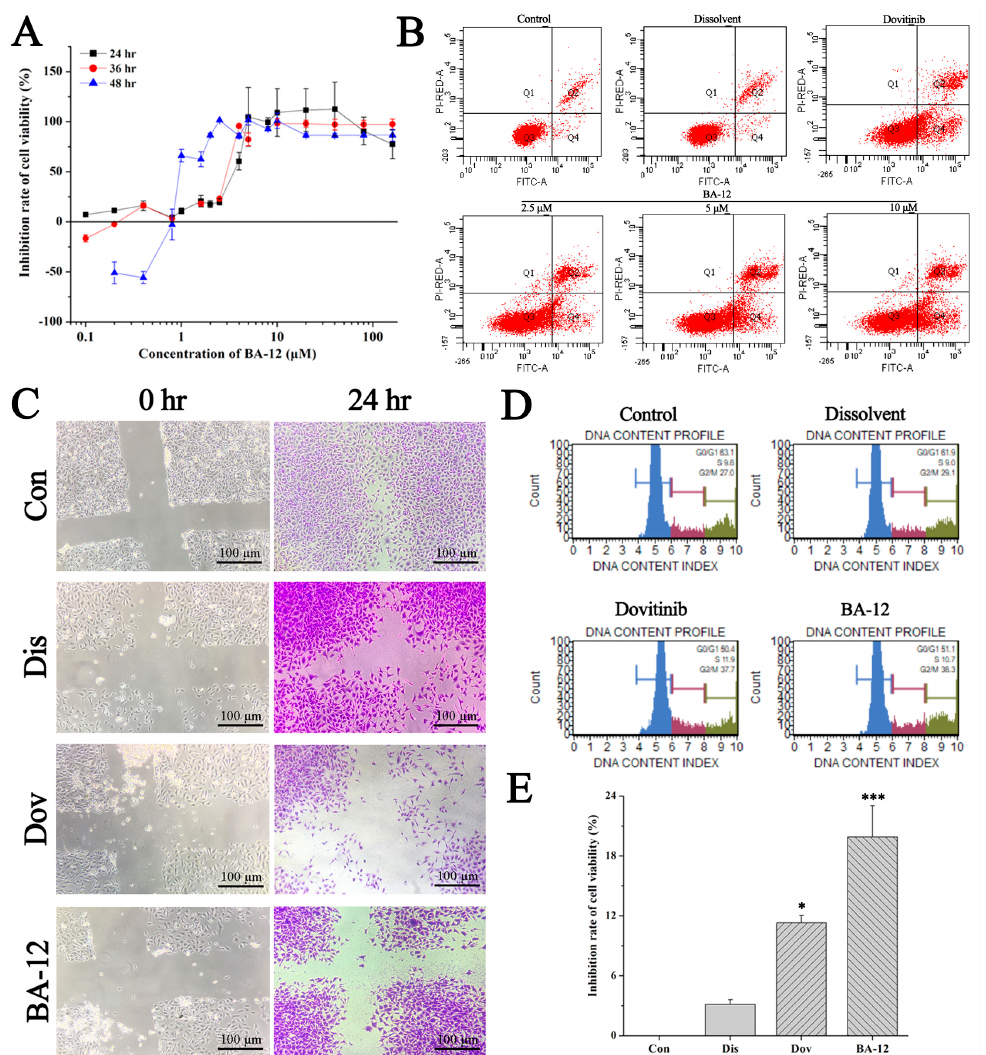
Figure 3. The in vitro antitumor activity of BA-12 on T24 cells. ( A ) Inhibition rate of cell viability of T24 cells for MTT assays (cells treated with BA-12 at doses of 0.25–160 µ M) for 24, 48, and 72 h. ( B ) Apoptosis analysis of T24 cells induced by agents using Annexin V-fluorescein isothiocyanate (FITC) / propidium iodide (PI) staining. ( C ) Results for wound scratch assay (cells treated with BA-12 at doses of 2.5 µ M) after 24 h under the microscope (100 × ). The most representative fields are shown. ( D ) Cell cycle analysis using PI staining (cells treated with BA-12 at doses of 2.5 µ M). ( E ) Inhibition rate of cell viability of T24 cells for MTT assays (cells treated with BA-12 at doses of 2.5 µ M) for 24 h. ANOVA with a post hoc test was used to calculate the significance of the di ff erences; * p < 0.05, *** p < 0.001 compared with the dissolvent group. Experiments were executed three times. Results are displayed as means ±